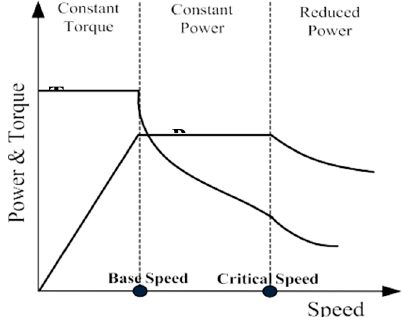
Figure 8. EM Standard Torque/speed Characteristics.